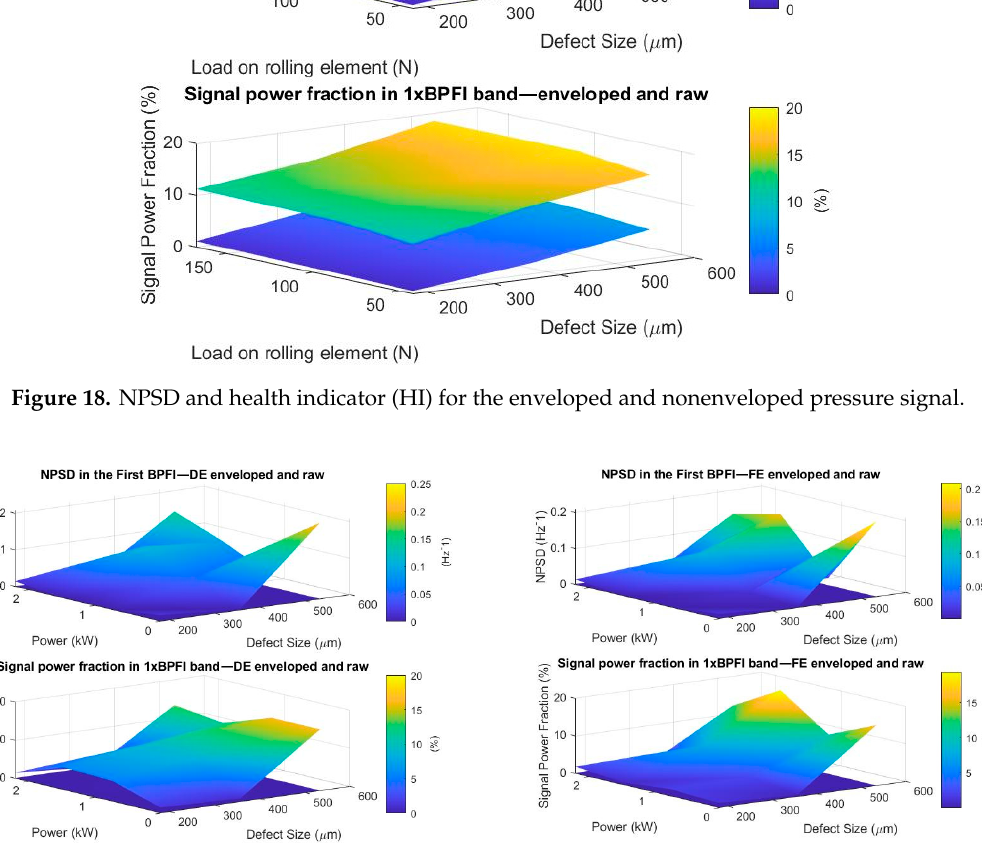
Figure 18. NPSD and health indicator (HI) for the enveloped and nonenveloped pressure signal.